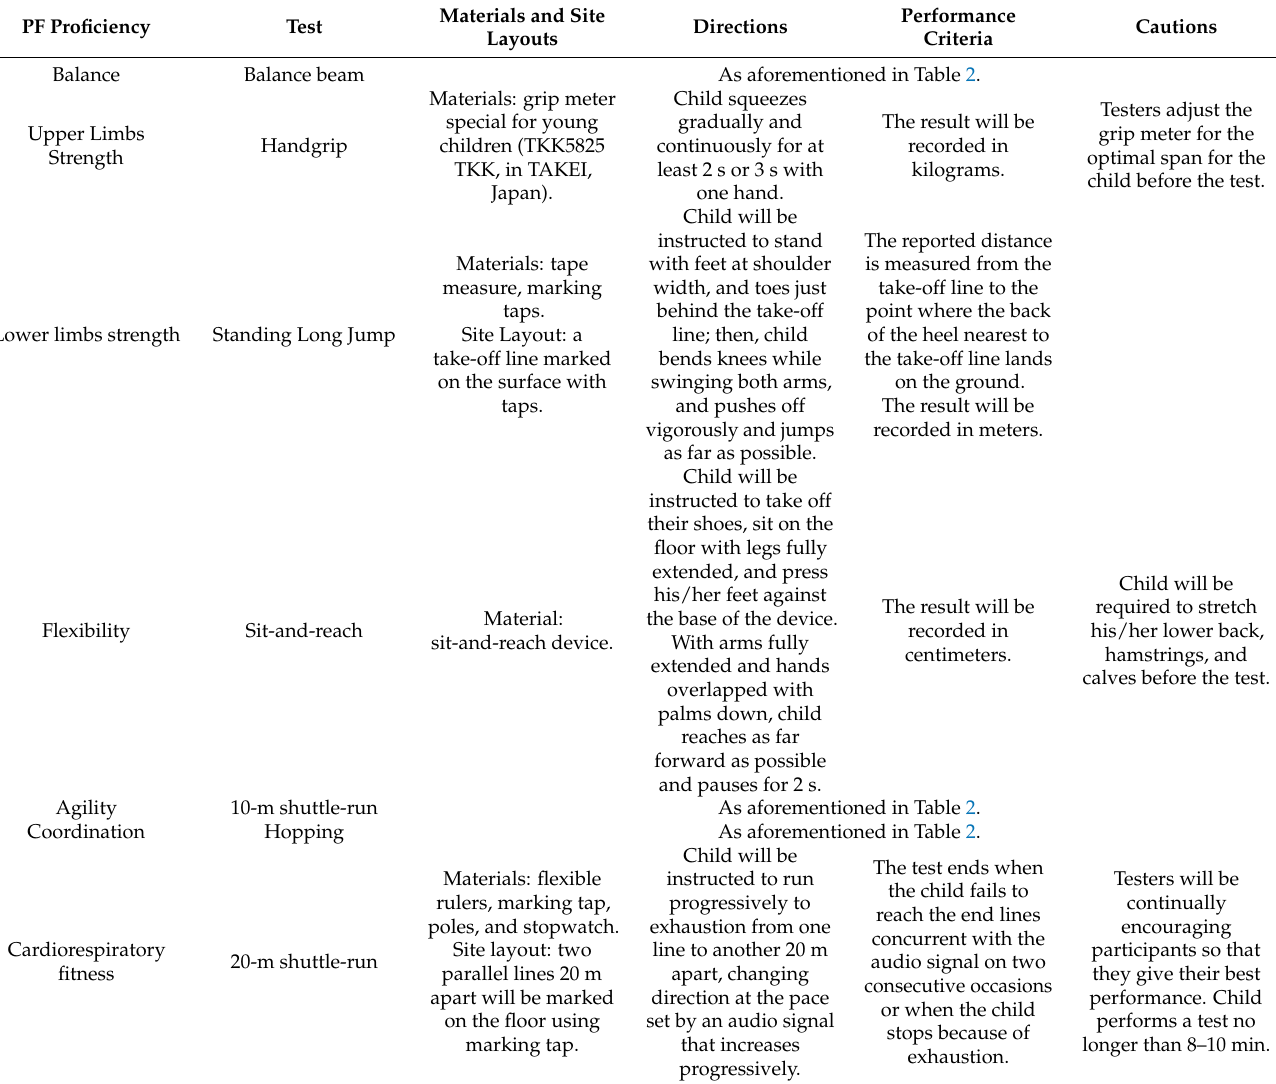
Table 3. Physical Fitness